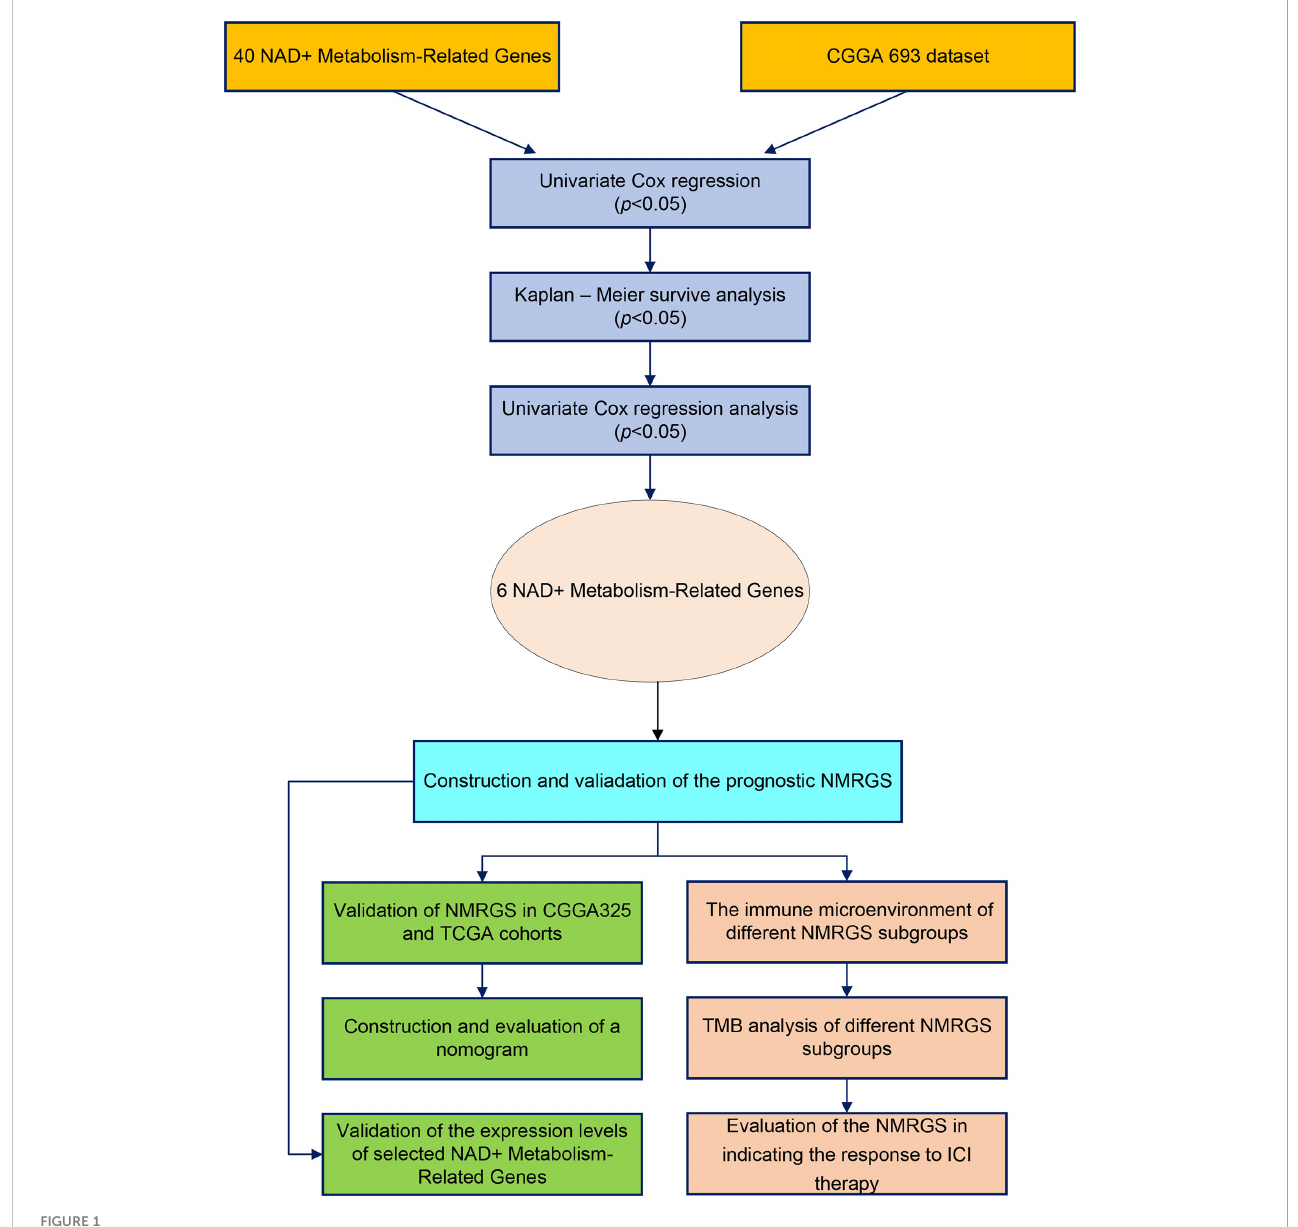
FIGURE 1 Flow chart of this